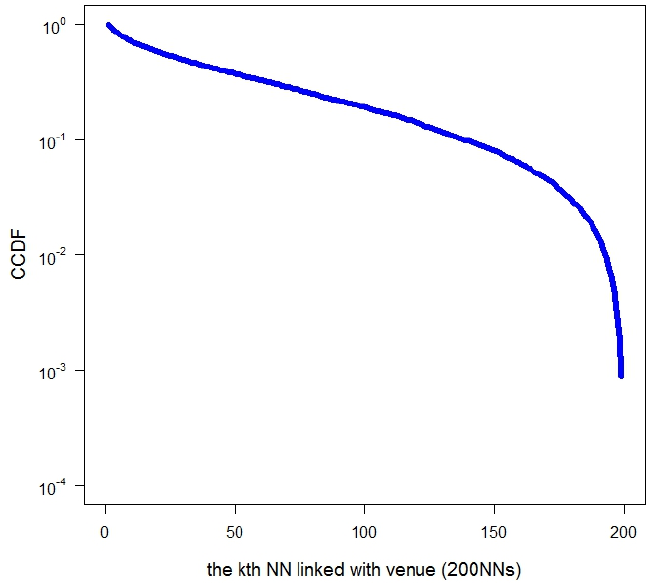
Figure 3. CCDF of the kth NN linked with a venue among 200NNs ( P ( x ) ~𝑒 −λ𝑥 , λ = 0.022).